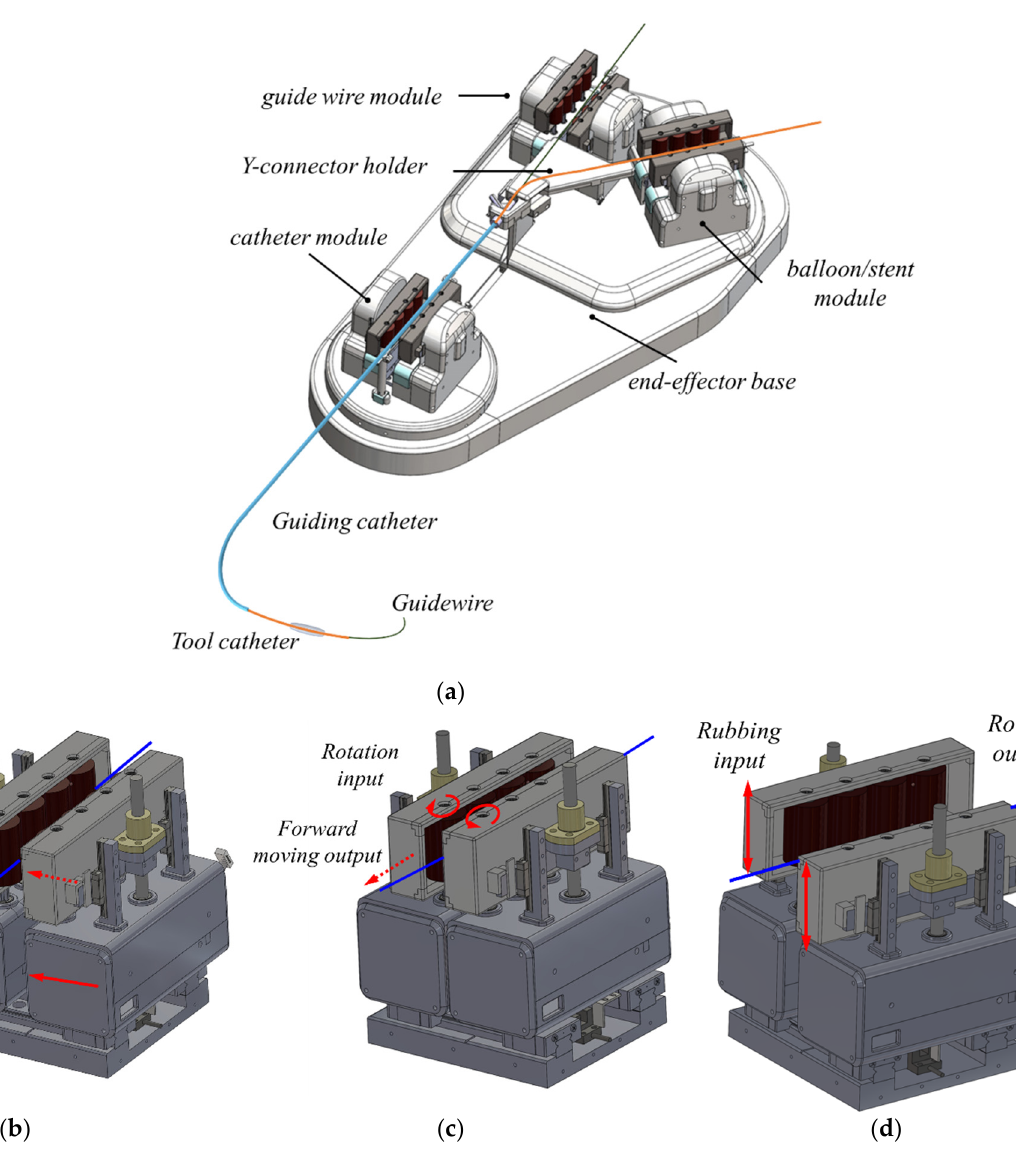
Figure 2. ( a ) The slave end-effector and the motion principles of ( b ) clamping mechanism, ( c ) translation mechanism, and ( d ) rotation mechanism in the roller module.